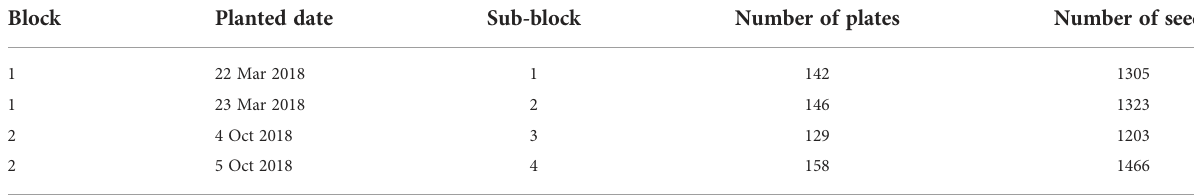
TABLE 1 Planting dates and numbers of seeds used in the growth experiment.